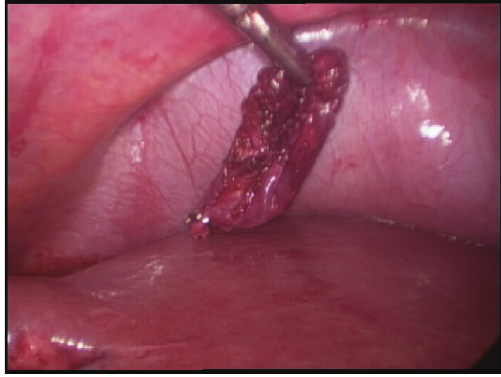
Figure 5: Cystic duct and artery divided and gallbladder remnant separated